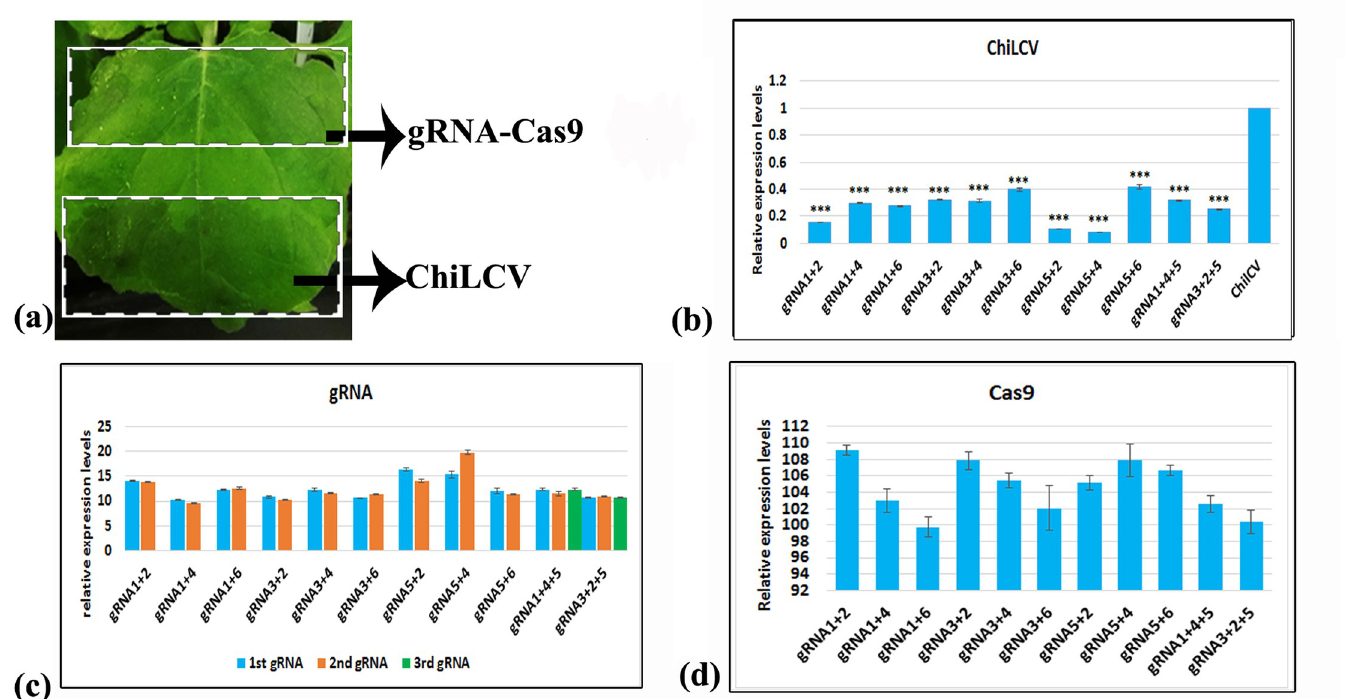
Fig 3. In planta expression assay. a) Inoculation positions of gRNA-Cas9 construct and ChiLCV, b) qPCR assay to understand reduction of viral replication, c) qRT-PCR assay for gRNA expression analysis, d) qRT-PCR assay for Cas9 expression analysis. For qPCR and qRT-PCR, three replicates were used for each data point. The error bar denotes SEM. Stars indicate significant difference (student’s unpaired t-test) of ChiLCV expression levels between gRNA-Cas9 treated and non-treated plants ( � P < 0.05, �� P < 0.01, ��� P < 0.001).